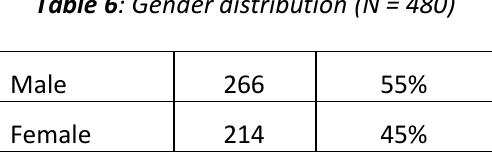
Table 6 : Gender distribution (N =